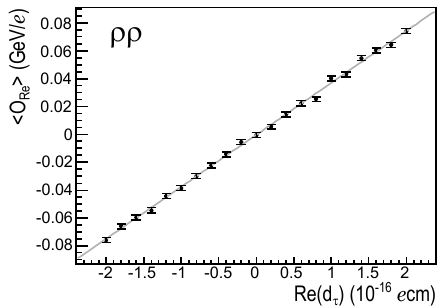
Figure 4 . Relation of Re( d τ ) and hO Re i for the ρρ mode obtained by the MC simulation. The line shows the fitted function. Other modes also show a similar linear dependence; the non-linearity is negligible for all modes.